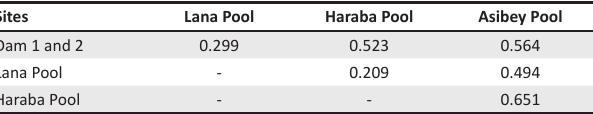
TABLE 3: Species similarity among the four study sites in Mole National Park, as shown by the quantitative Morisita–Horn index (C MH ). Sites Lana Pool Haraba Pool Asibey Pool